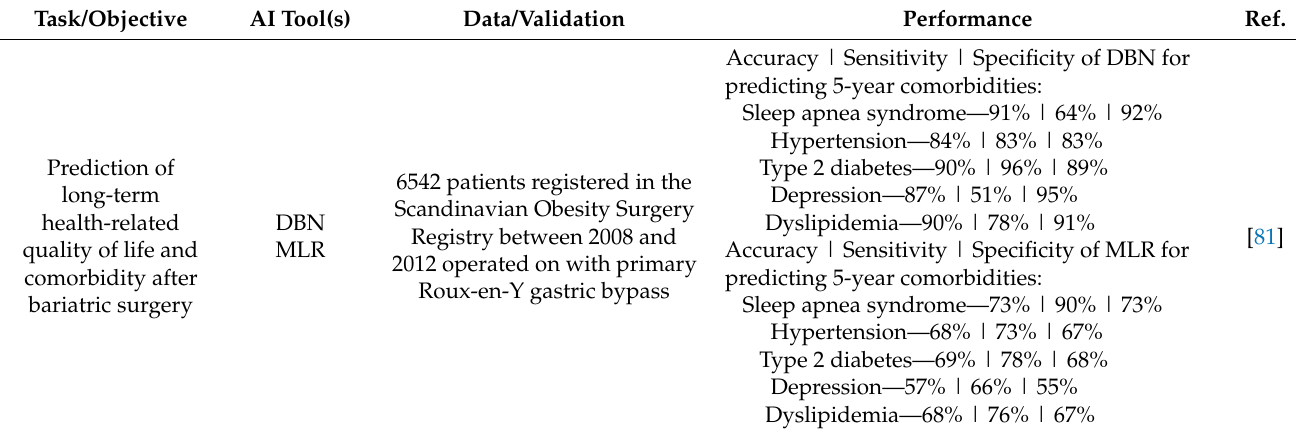
Table 7. Summary of the recent AI studies in gastroenterology and